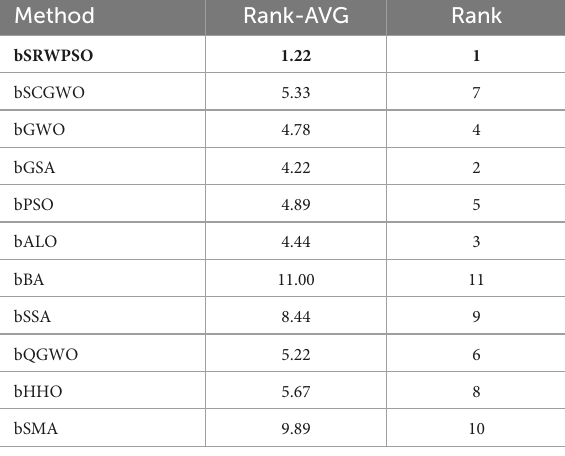
TABLE 14 The results of Friedman ranking for